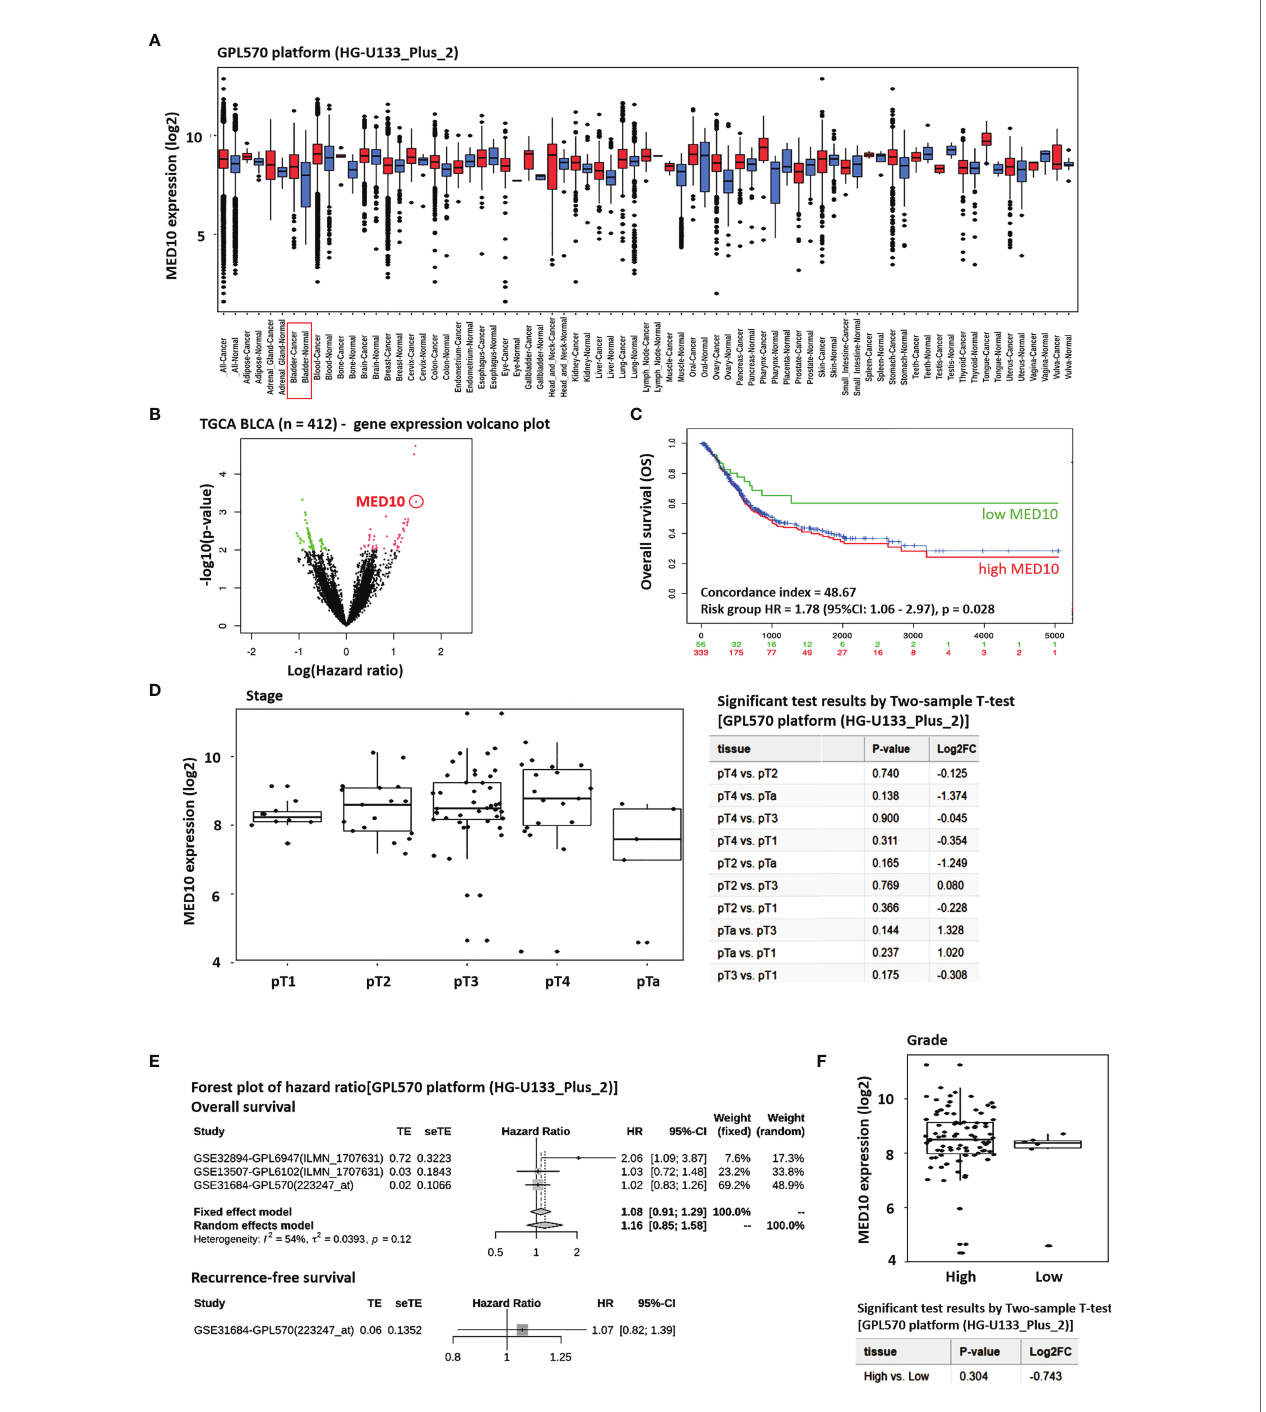
FIGURE 1 | MED10 is aberrantly expressed in patients with BLCA, and this has an adverse prognostic implication. (A) Box plot of the tissue-wide differential gene expression pro fi le across cancer experiments using the GPL570 platform (HG-U133_Plus_2)]. (B) Volcano plot of the hazard ratios of differentially expressed genes in the TGCA BLCA cohort. MED10 is indicated by the red circle. Volcano plot was plotted with log hazard ratio (HR) on the x-axis and p-value on the y-axis, using the Cox PH model. (C) Kaplan – Meier plot showing the effect of altered MED10 expression on the overall survival of patients in the BLCA cohort of the GPL570 platform. (D) Box and dot plots showing the association between MED10 expression and tumor stage in the GPL570 platform BLCA cohort (left) . Chart showing the 2-sample t-test results for (D) (right) . (E) Forest plot of hazard ratios showing the effect of MED10 on overall and recurrence-free survival on the GPL570 platform BLCA cohort. (F) Box and dot plots of the MED10 expression pro fi le based on tumor grade in the GPL570 platform BLCA